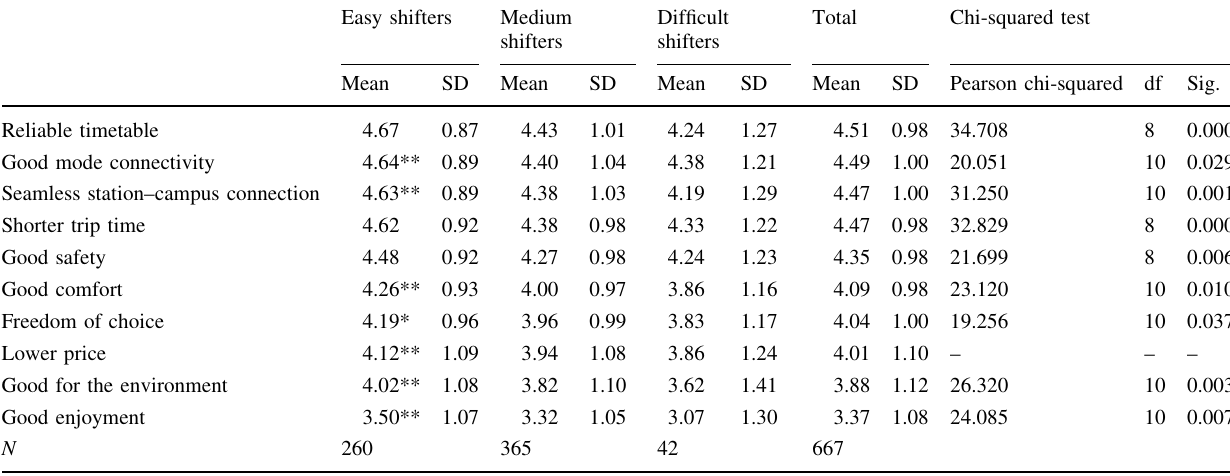
Table 4 Mean values of 10 factors that could facilitate respondents’ shift to metro with results for chi-squared test Easy shifters Medium Difficult Total Chi-squared test shifters shifters Mean SD Mean SD Mean SD Mean SD Pearson chi-squared df Sig. Reliable